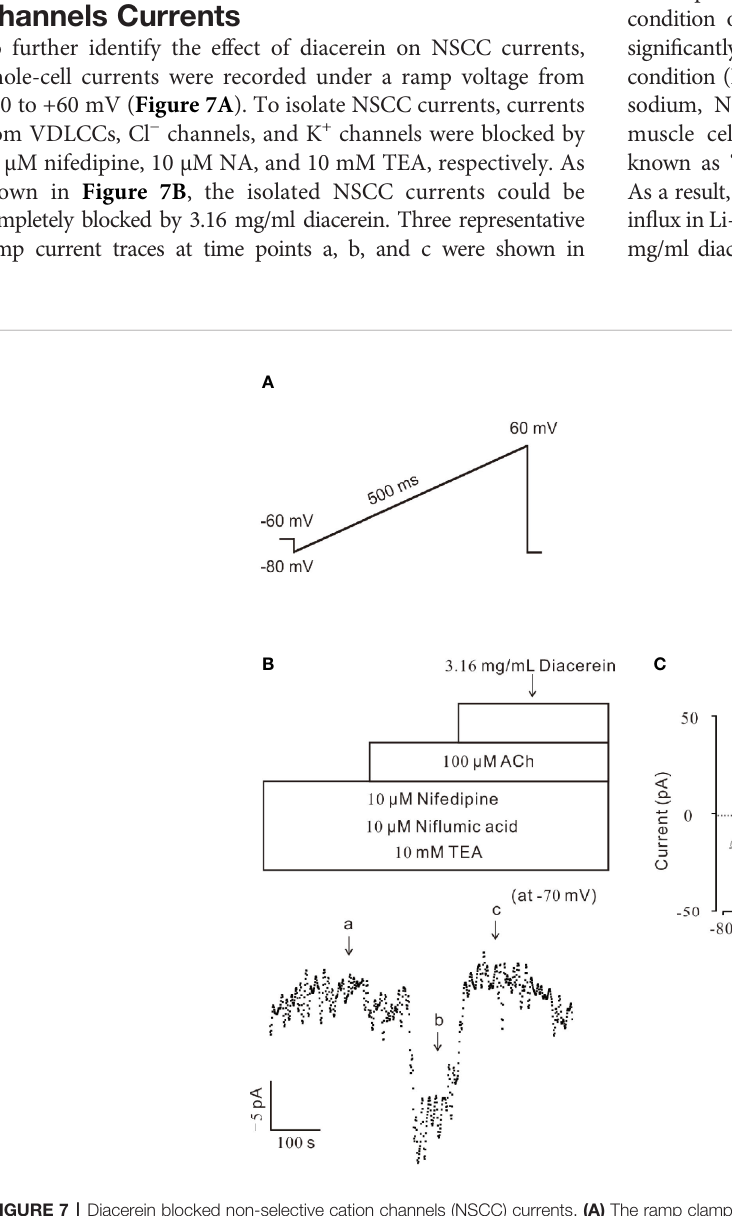
Figure 7C . This result indicated that diacerein could inhibit ACh- induced NSCC currents.